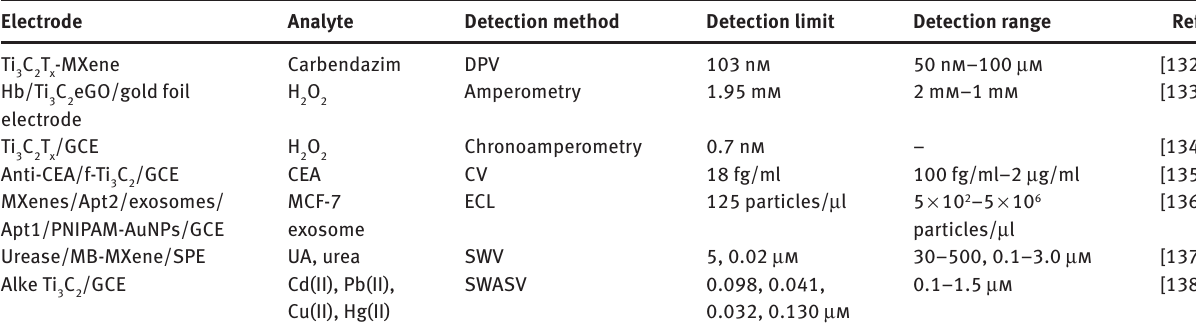
Table 3: Comparison of different electrodes according to their types of analytes and detection parameters.